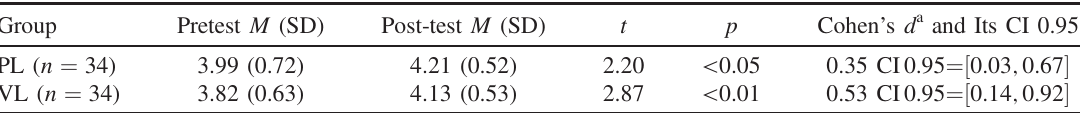
TABLE V. Means, standard deviations, and comparisons of enjoyment. Group Pretest M